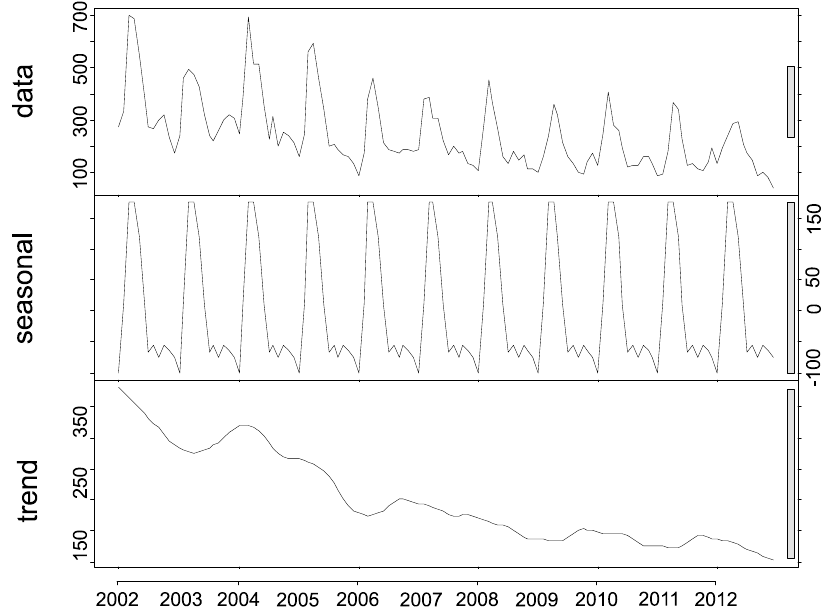
Figure 6. Seasonal decomposition of frequency of asthma hospitalizations in children and adolescents